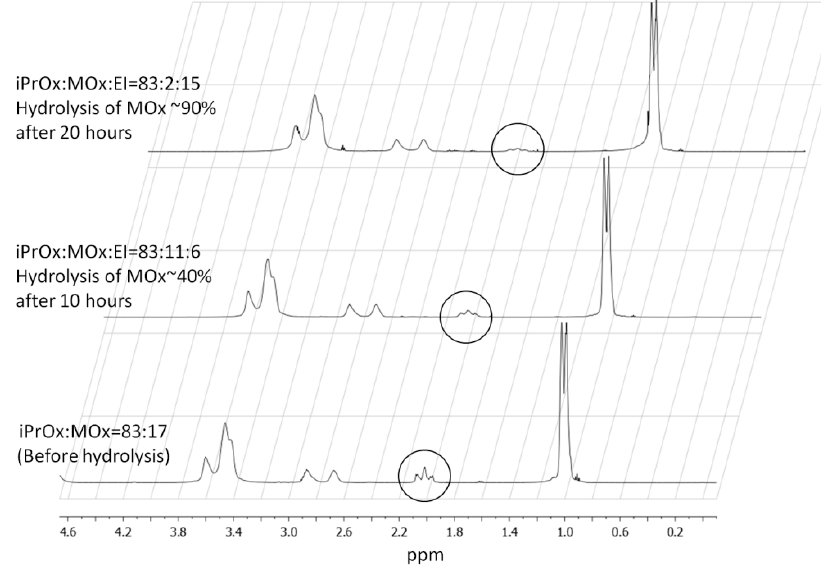
Figure 7. 1 H NMR spectra of P(iPrOx-MOx)2 during hydrolysis (CDCl 3